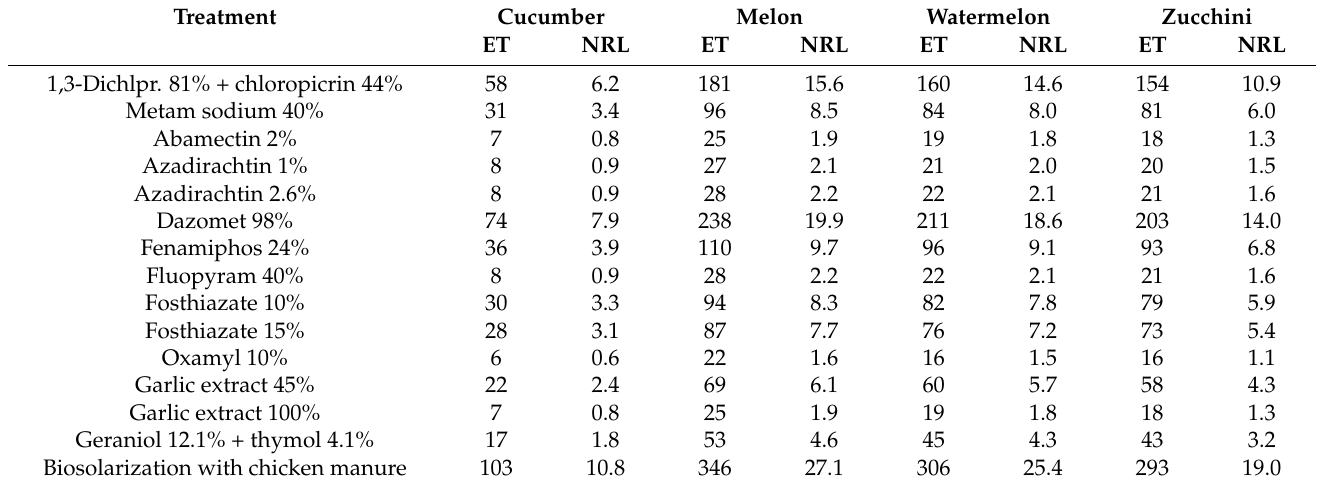
Table 5. Root-knot nematode ( M . incognita ) economic threshold (ET) and net return losses (NRL) at ET for various nematicidal treatments in intensive cucurbitaceous cultivation.